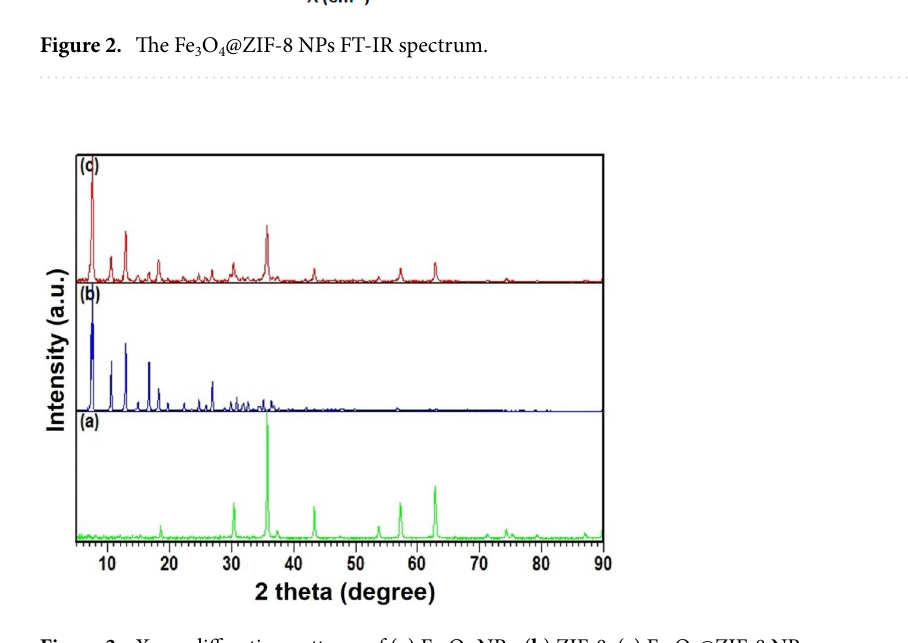
Figure 3. X-ray diffraction patterns of ( a ) Fe 3 O 4 NPs, ( b ) ZIF-8, ( c ) Fe 3 O 4 @ZIF-8